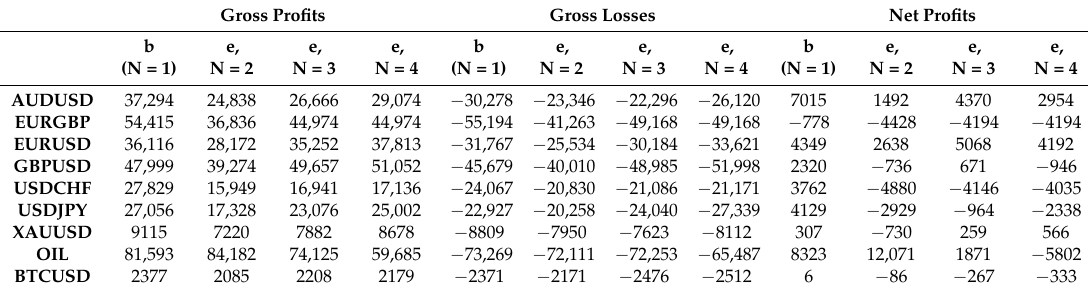
Table A5. Results of experiment (e) for various values of N.